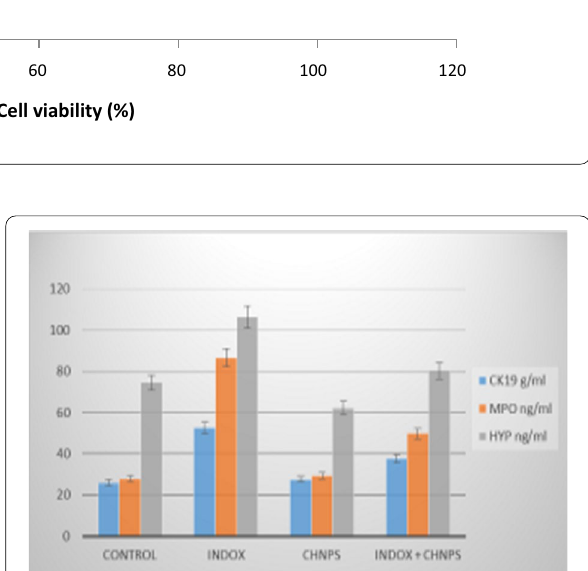
Values are expressed as mean standard error (SE) (10 rats/group) ± a Significant changes when compared with the group 1 at P < 0.05 b Significant changes when compared with the INDOX group at P < 0.05 Table 4 The effects of Ch-NPs TPP on the SOD and GPx serum levels in rats